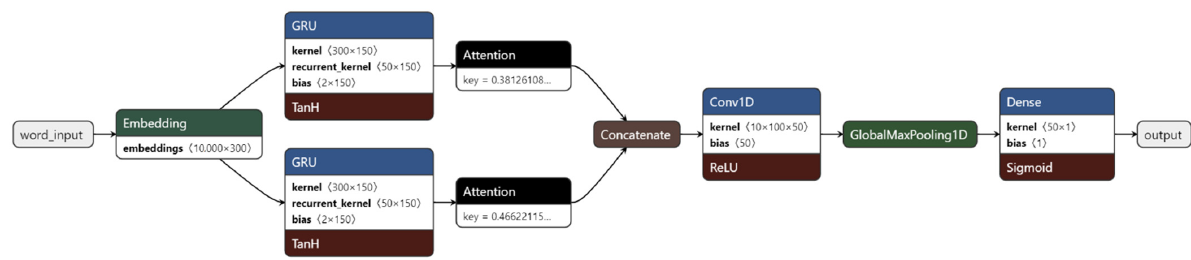
Figure 5. Implemented GRU ‐ CNN with separated forward and backward encoding.